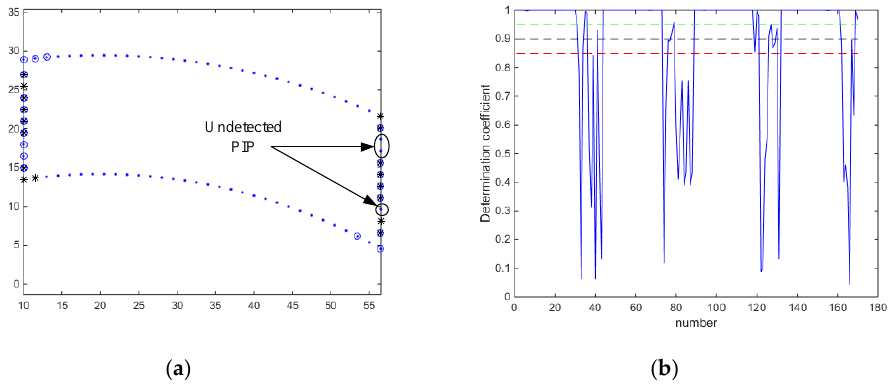
Figure 13. PIP detection with window width of 3; ( a ) Effects on PIP detection; ( b ) Determination coefficient of the sliding window at each point and the set threshold 0.85 (red), 0.9 (black), 0.95 (green).